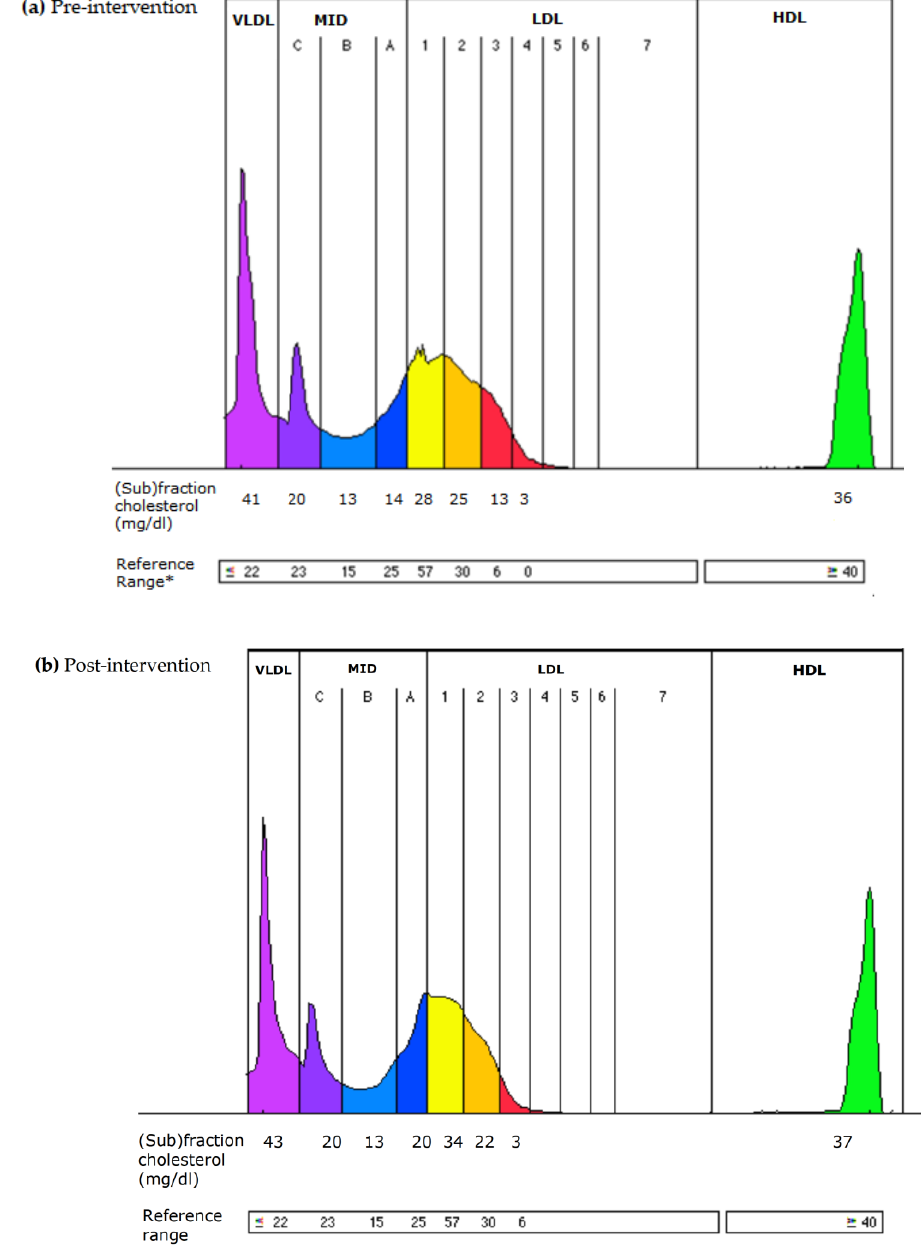
Figure 2. Changes in LDL lipoprotein subfractions in women with atherogenic phenotype B after the consumption of apple/berry juice for 6 weeks. ( a ) Pre-intervention: LDL phenotype B with atherogenic LDL3-7 subfractions (in red) and large-less atherogenic subfractions LDL1-2 in yellow; ( b ) post-intervention: LDL phenotype A almost without atherogenic LDL subfractions; LDL3-7 (in red) and large-less atherogenic subfractions LDL1-2 in yellow.